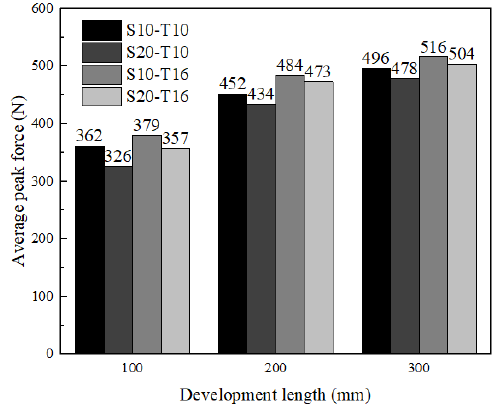
Figure 7. Average peak force of each series.